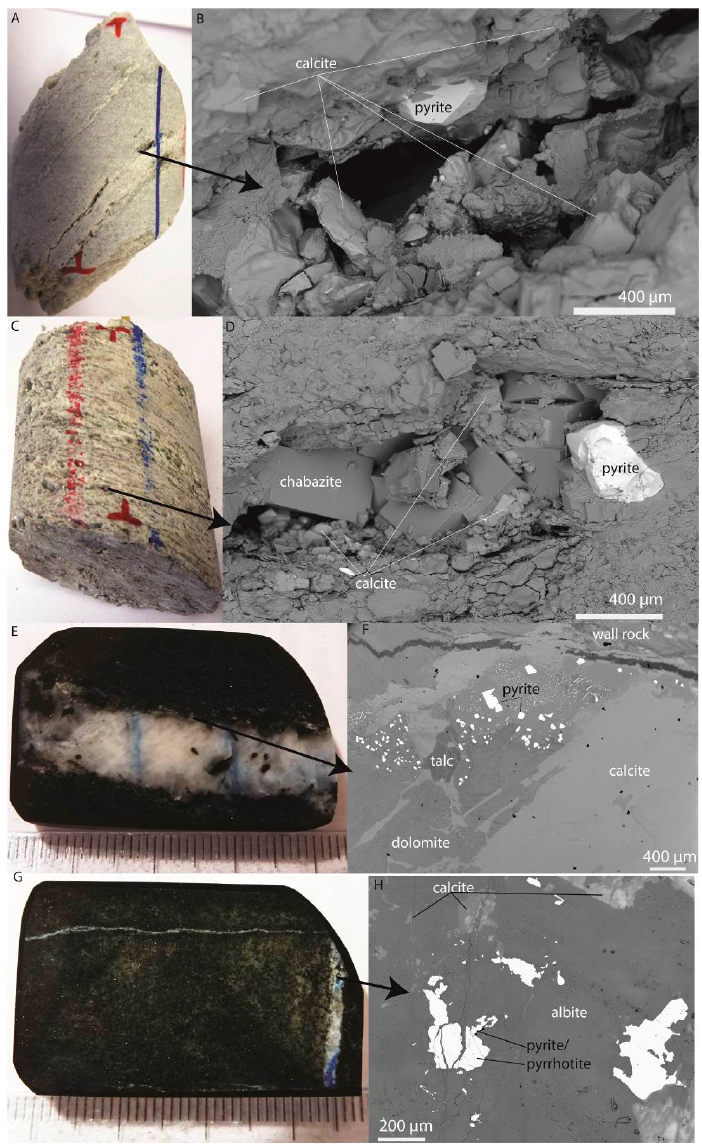
Figure 2. Mineral characteristics in photographed drill core samples (left) and back-scattered